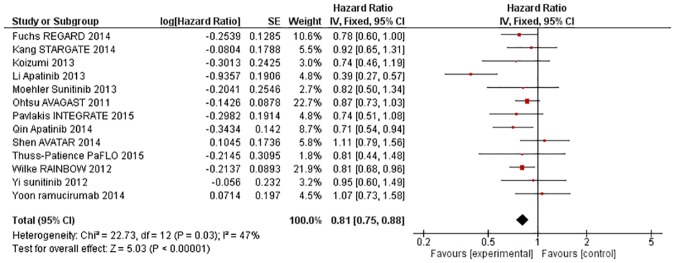
Forest plot—Overall Survival—all trials.